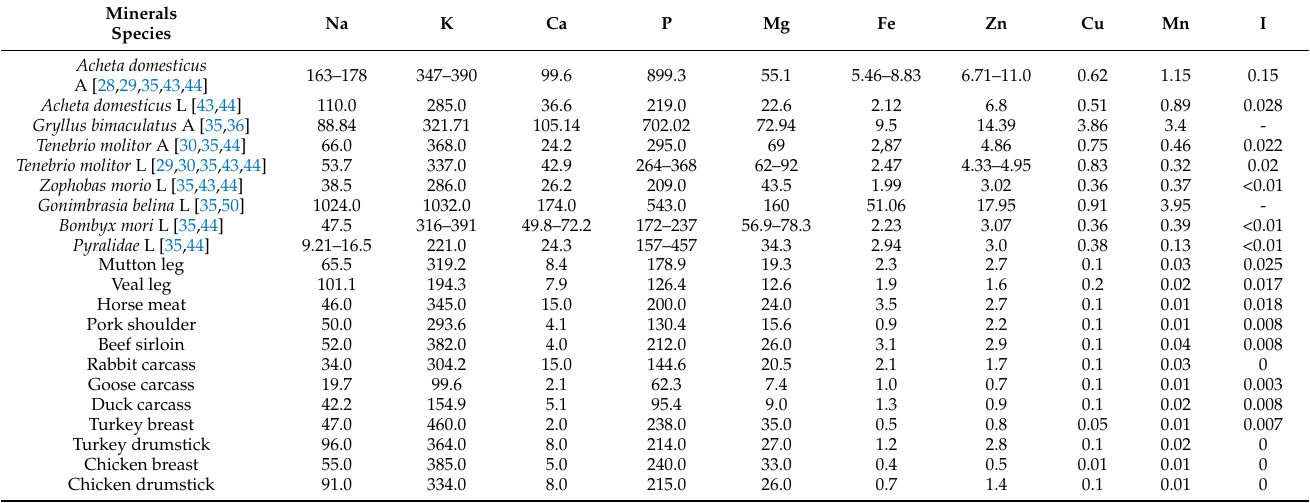
Table 6. Mineral contents of edible insects and meat (mg/100 g edible portion)